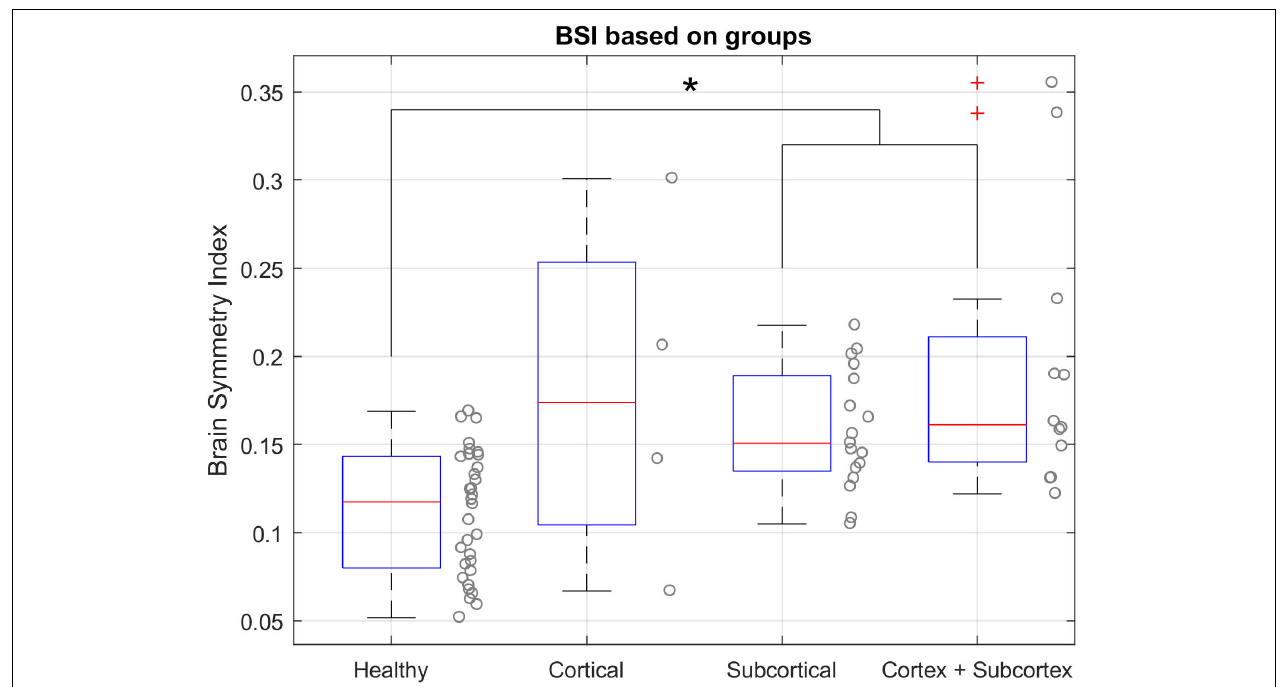
FIGURE 5 | BSI values in resting state with open eyes for each group. (*) Indicates the significant differences based on the Games-Howell test. The BSI of the healthy group is significantly different from the subcortical group and cortex + subcortex group. Healthy group median = 0.1173, IQR = 0.0799 – 0.1432. Cortical group = 0.1739, IQR = 0.1043–0.2534. Subcortical group = 0.1507, IQR = 0.1349–0.1890. Cortex + Subcortex group = 0.1612, IQR = 0.1400–0.2110.